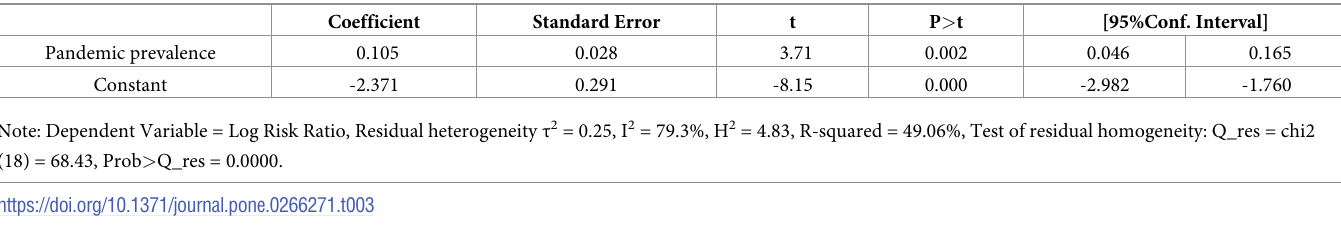
Table 3. Results of